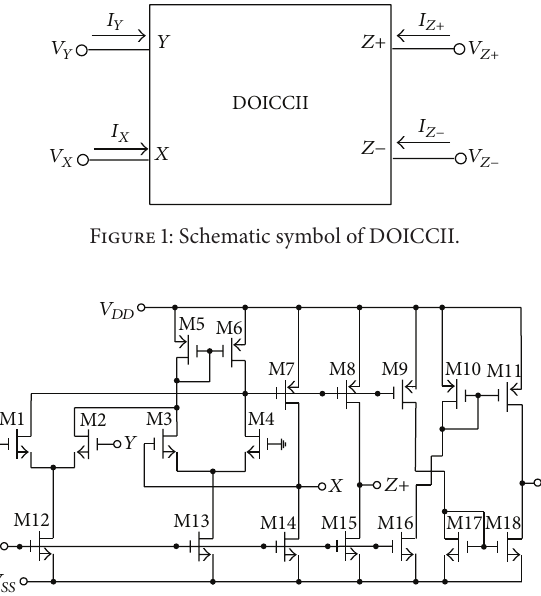
Figure 2: The CMOS implementation of